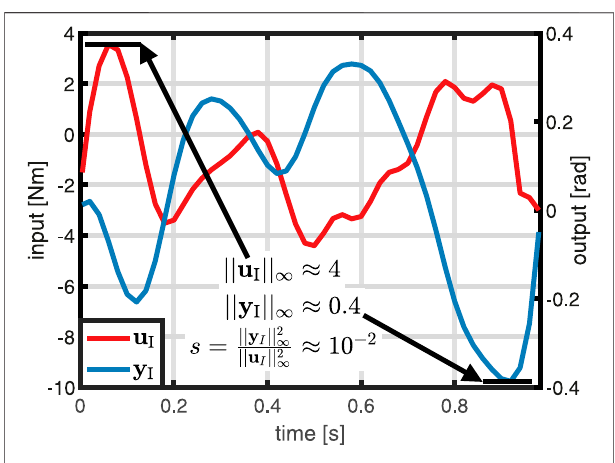
FIGURE7| Determinationoftheweight s :Basedonthemaximaofinput and output trajectory in an initial trial, the weight s is chosen according to (27).